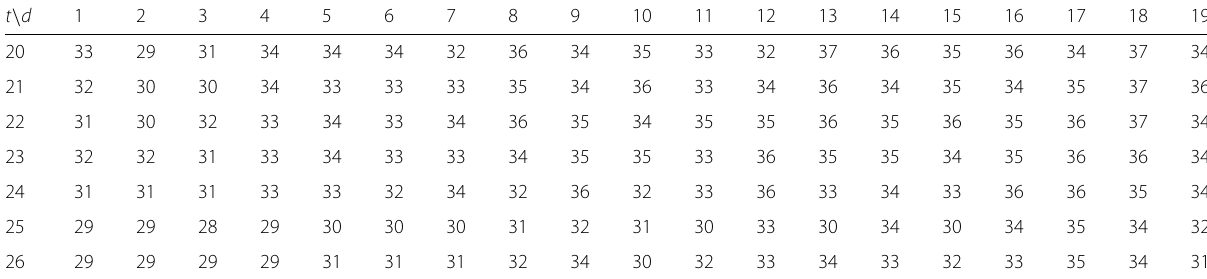
Table 3 Same-day predictions of demand